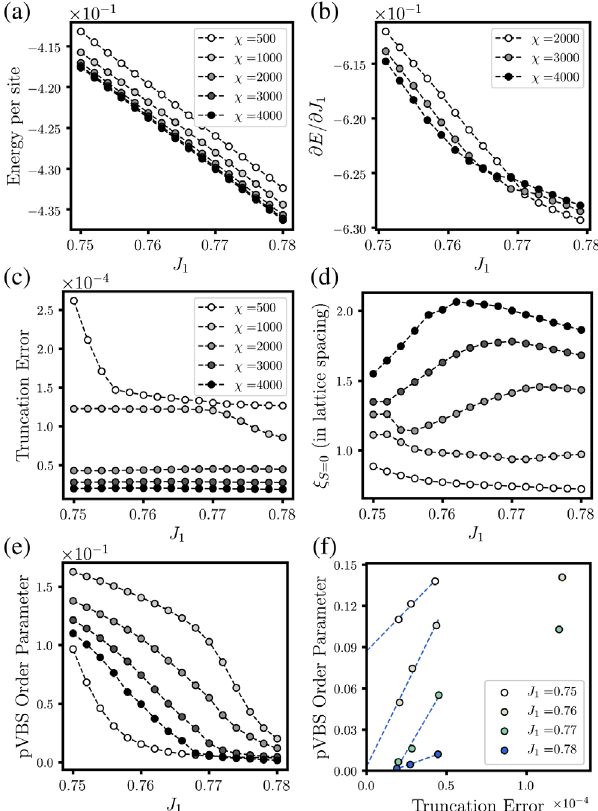
FIG. 16. The IDMRG simulation results with Δ J 1 ¼ 0 . 002 at L ¼ 10 , shown for a range of the IDMRG bond dimension χ . Bond dimension scalings of the (a) energy per site E , (b) energy derivative per site ∂ E= ∂ J 1 (data for χ ¼ 500 , 1000 are not shown here, as these data points behave irregularly and cover the other data points, which can happen at a low bond dimension, for which the IDMRG simulation does not converge properly), (c) truncation error p , (d) correlation length of spin-singlet operator ξ , and (e) PVBS order parameters. Here, (c) – (e) S ¼ 0 share the same labels for different bond dimensions. Note that the correlation length is plotted, not the inverse as in Fig. 4. In (f), we plot PVBS order parameters as functions of truncation errors for a range of the tuning parameter J 1 . The blue dotted line is a linear fitting for the three data points at χ ¼ 2000 , 3000,